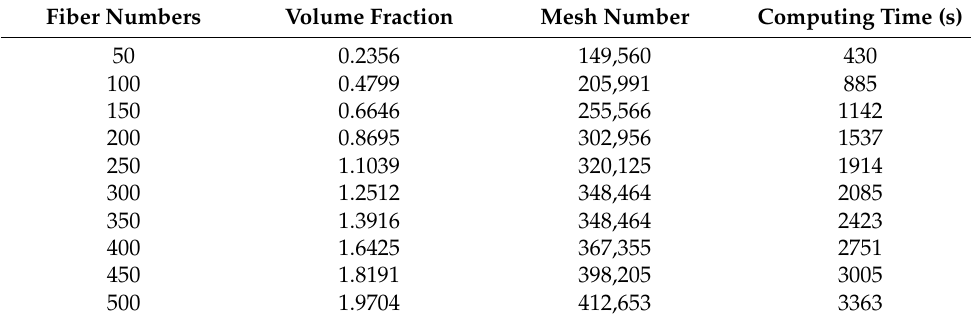
Table 3. Fiber integration in the generated finite element models.